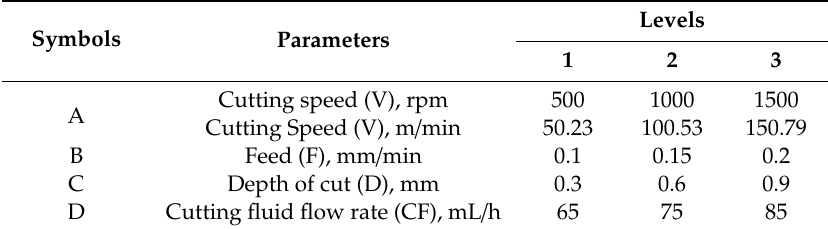
Table 2. Process parameters and levels.